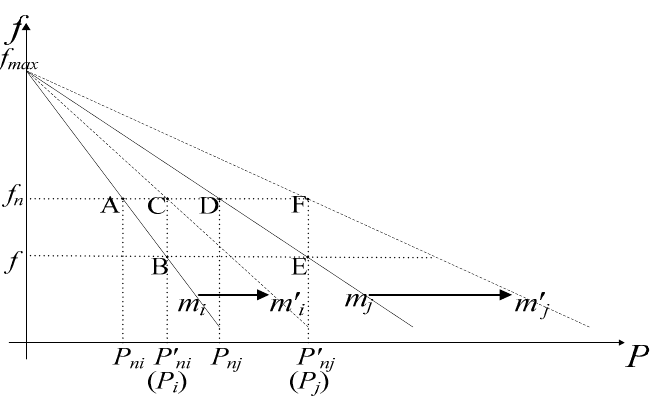
Figure 2. Conventional and improved P - f droop control characteristics.